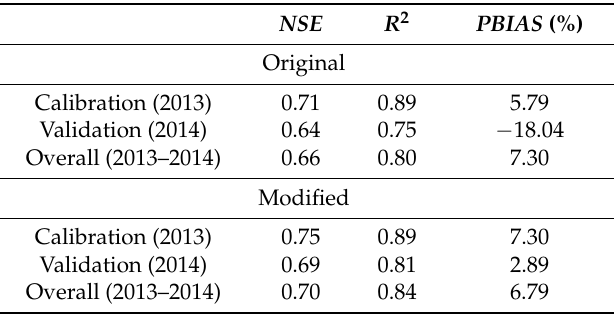
Table 3. Daily streamflow calibration and validation results for the Tizinafu River Basin, Kunlun Mountains, Western China. NSE R 2 PBIAS (%) Original Calibration (2013) 0.71